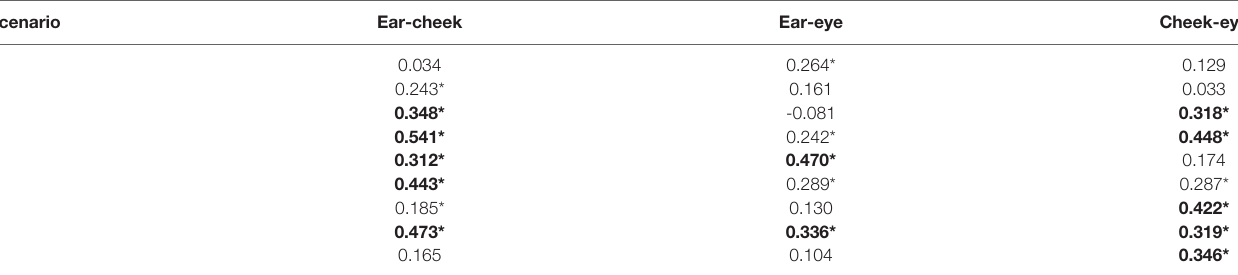
TABLE 4 | MTMM Monotrait Heteromethod Correlations for all PGS raters (n=123) per scenario (* = polychoric correlation signi fi cantly different from 0, p< 0.05; bolded = magnitude > 0.3). Scenario